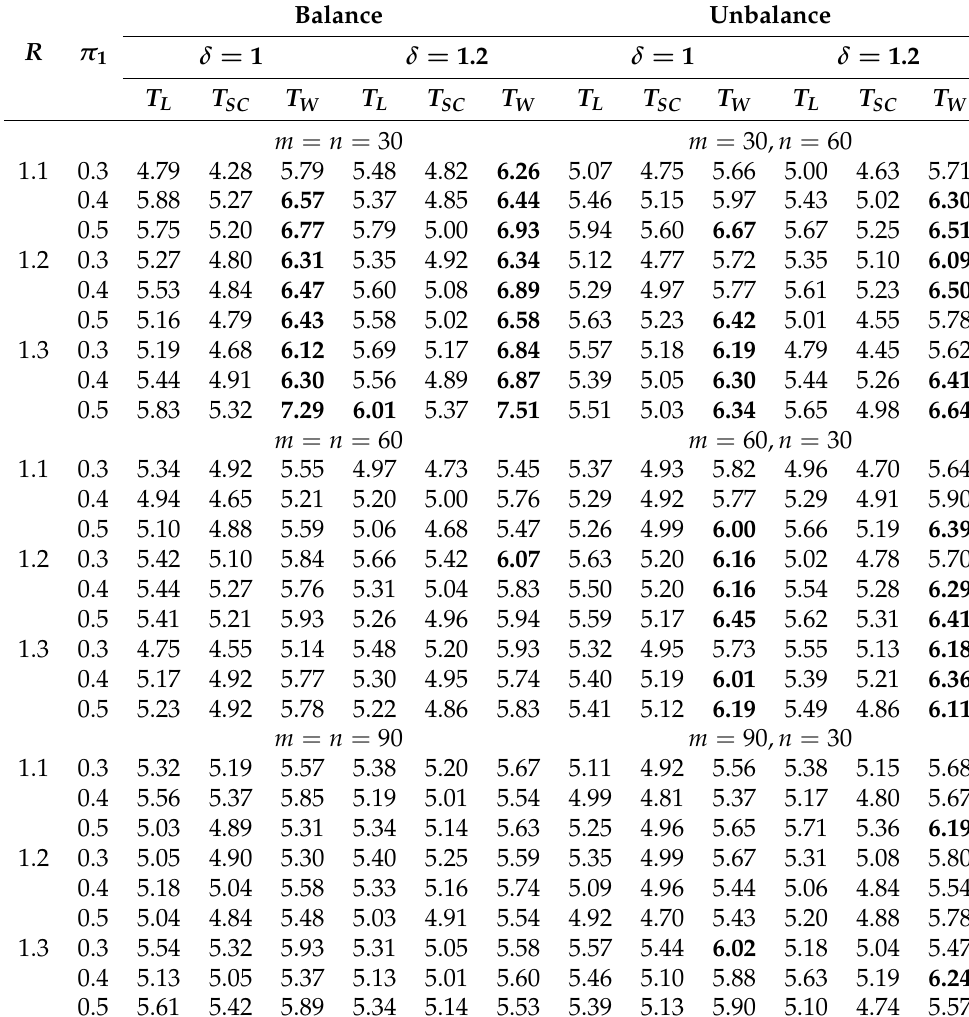
Table 5. The empirical TIEs (%) of tests under H 0 : δ i = δ ( g = 5, α =